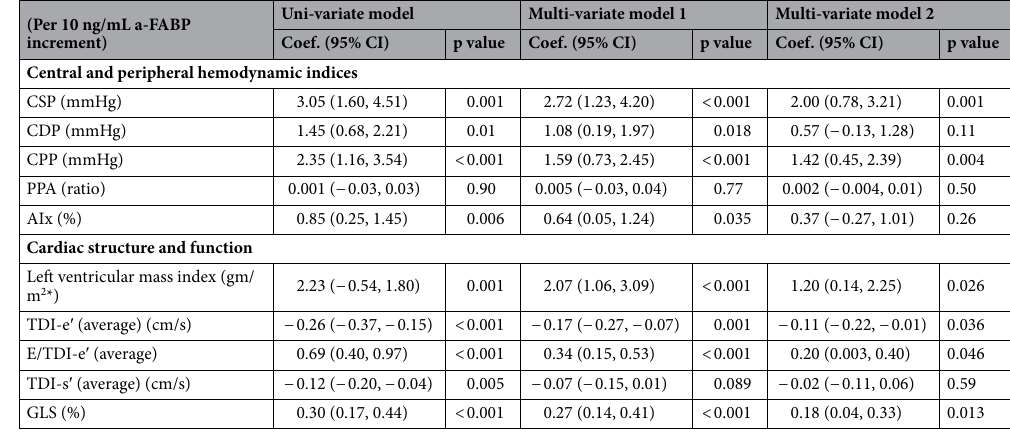
Table 2. Associations of a-FABP with central hemodynamic indices and key cardiac structural and functional parameters. *In which model body mass index was not entered. Multi-variate Model 1: Adjusted for age, gender; Multi-variate Model 2 : Model 1 plus body mass index (BMI), hypertension (yes/no), diabetes mellitus (yes/no), active smoking status (yes/no), coronary artery disease (yes/no), stroke (yes/no), renal function (eGFR). AIx, aortic augmentation index; CSP, central systolic pressure; CDP, central diastolic pressure; CPP, central pulse pressure; GLS, global LV longitudinal systolic myocardial strain; PPA, peripheral pulse pressure amplification; TDI-e ′ , peak myocardial diastolic relaxation velocity on tissue-based Doppler; E/TDI-e ′ , mitral inflow E wave divided by TDI-e ′ ; TDI-s ′ , peak myocardial systolic relaxation velocity of tissue-based Doppler.